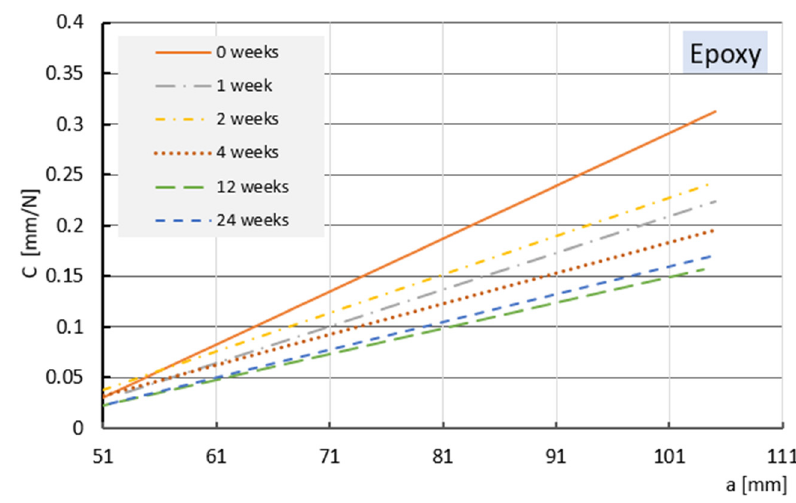
Figure 11. Trend lines in flexibility growth phase versus delamination length for epoxy adhesive.